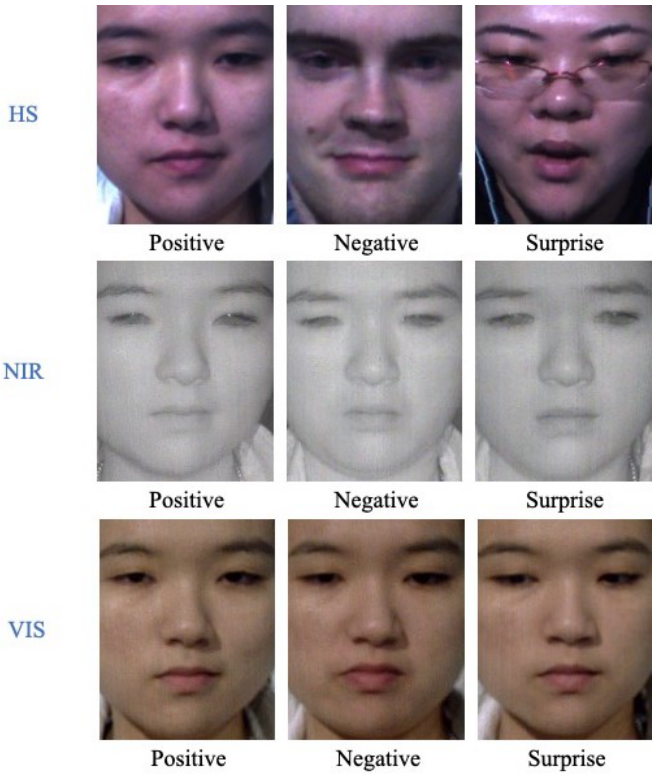
Figure 10. Examples of frames from sequences in the three subsets of the Spontaneous Micro- expression Corpus (SMIC), namely SMIC-HS, SMIC-VIS, and SMIC-NIR [41].